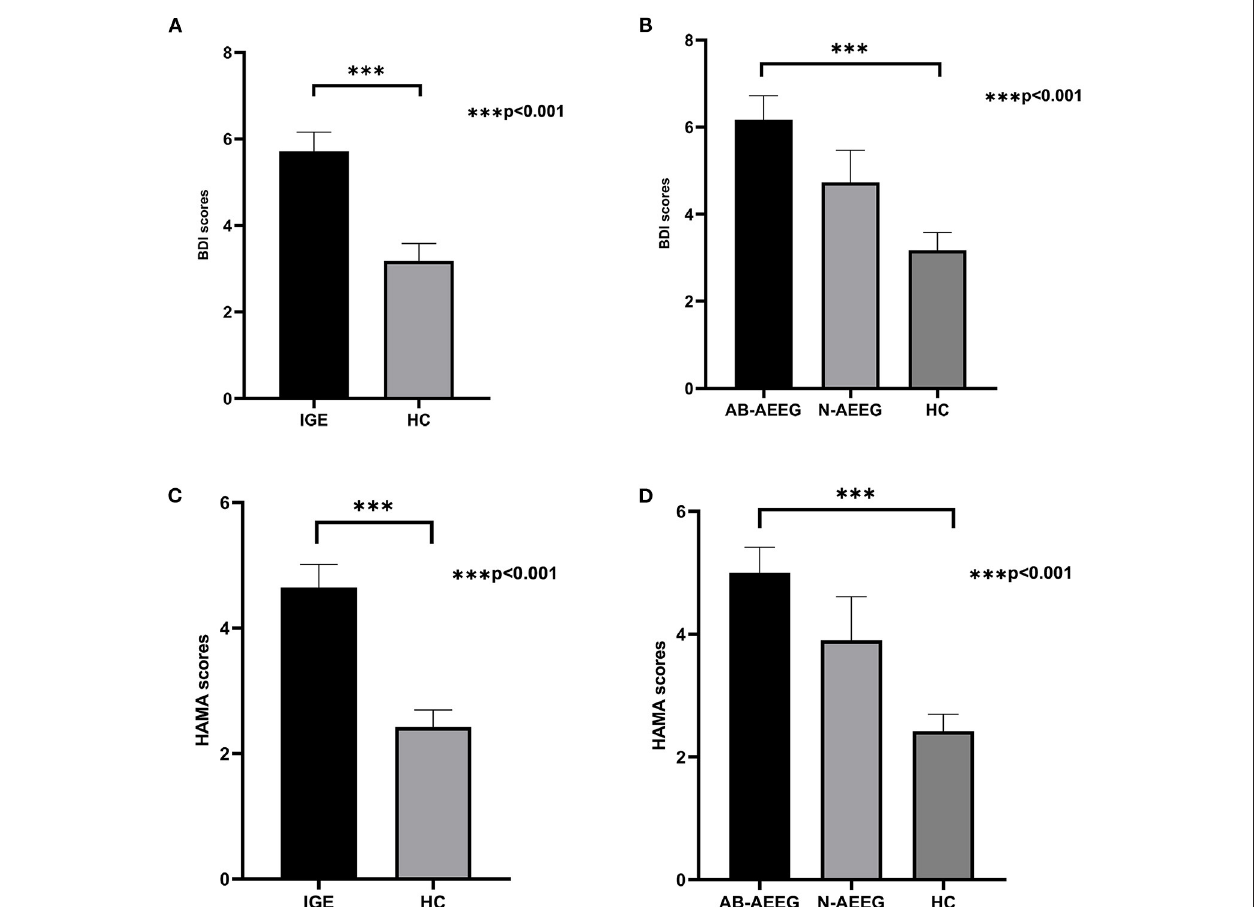
FIGURE 1 | Differences in BDI and HAMA scores among groups. IGE, idiopathic generalized epilepsy; AB-AEEG, abnormal ambulatory electroencephalogram; N-AEEG, normal ambulatory electroencephalogram; HC, healthy control; BDI, Beck Depression Inventory; HAMA, Hamilton Anxiety Scale. (A) BDI score was higher in the IGE group than HC group ( Z = − 3.773, p < 0.001). (B) BDI scores of the three groups (AB-AEEG, N-AEEG, and HC). BDI score was higher in the AB-AEEG group than HC group ( χ 2 = 16.492, p < 0.001). (C) HAMA score was higher in the IGE group than HC group ( Z = − 4.109, p < 0.001). (D) HAMA scores of the three groups, The HAMA score was significantly higher in the AB-AEEG group than HC group ( χ 2 = 21.214, p < 0.001).